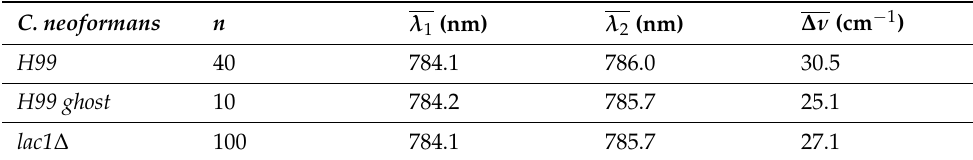
Table 3. Sample and laser parameters for C. neoformans